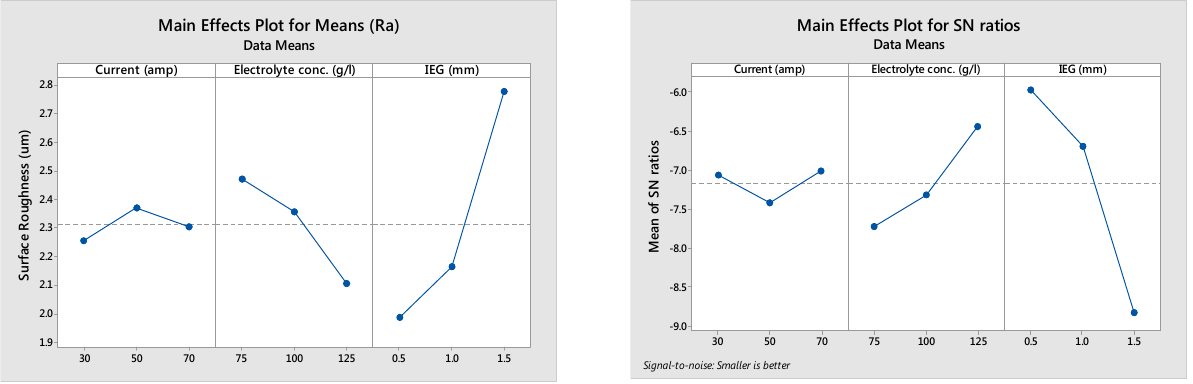
Fig. 4. Main effects Plot for means (Ra) Fig. 5. The mean S/N ratio plot for (Ra).